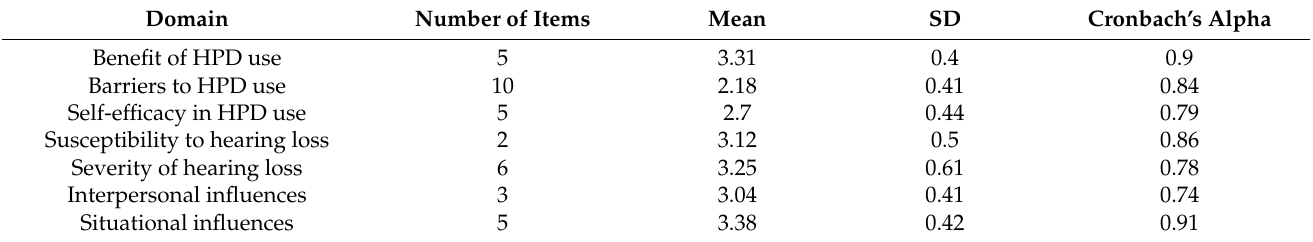
Table 1. Summary statistics and internal consistency measures of the predictors of HPD